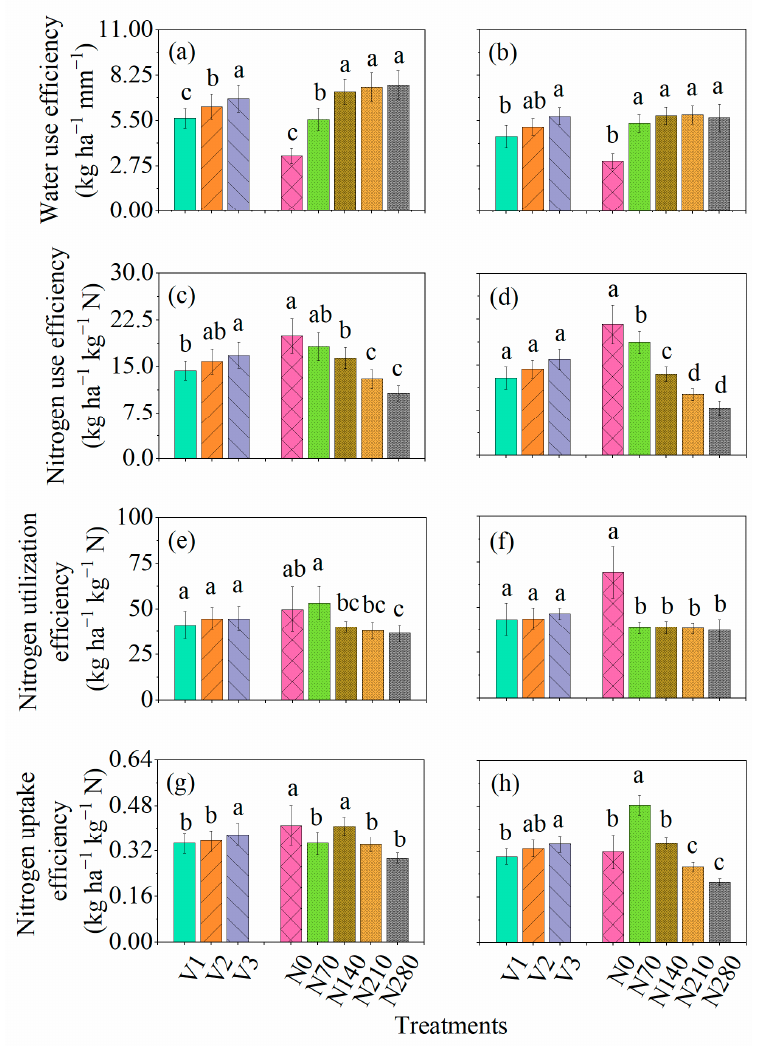
Figure 3. Response of ( a , b ) water use efficiency (kg ha − 1 mm − 1 ), ( c , d ) nitrogen use efficiency (kg ha − 1 kg − 1 N), ( e , f ) nitrogen utilization efficiency (kg ha − 1 kg − 1 N), and ( g , h ) nitrogen